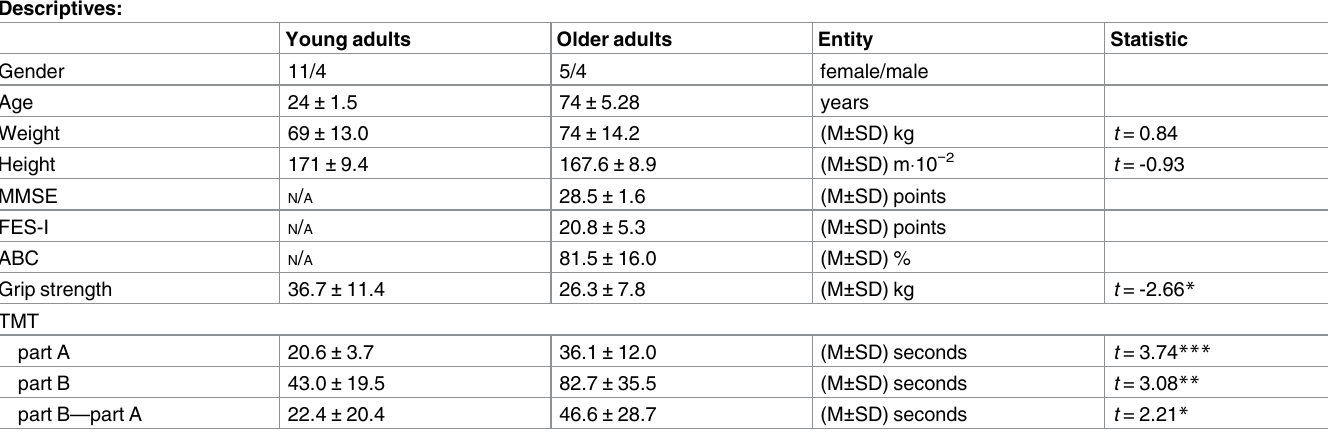
Table 1. Descriptivestatistics of participants in both age groups. The mean values (M) and standarddeviation(SD) is given for the different descriptives. Difference(t-statistics) between the two age groupsare shown ( * :p < 0.05, ** :p < 0.01, *** :p < 0.001).